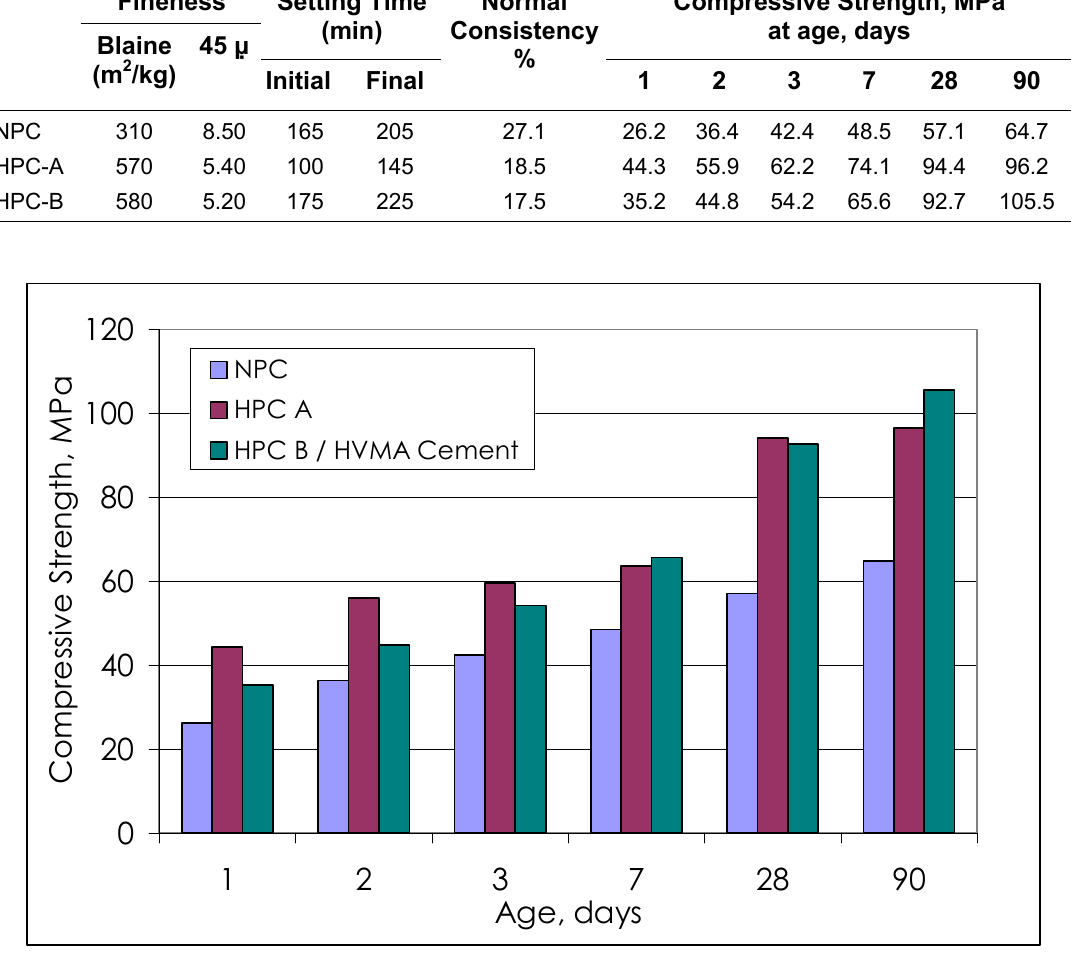
FIGURE 3 . HP/HVMA cement strength